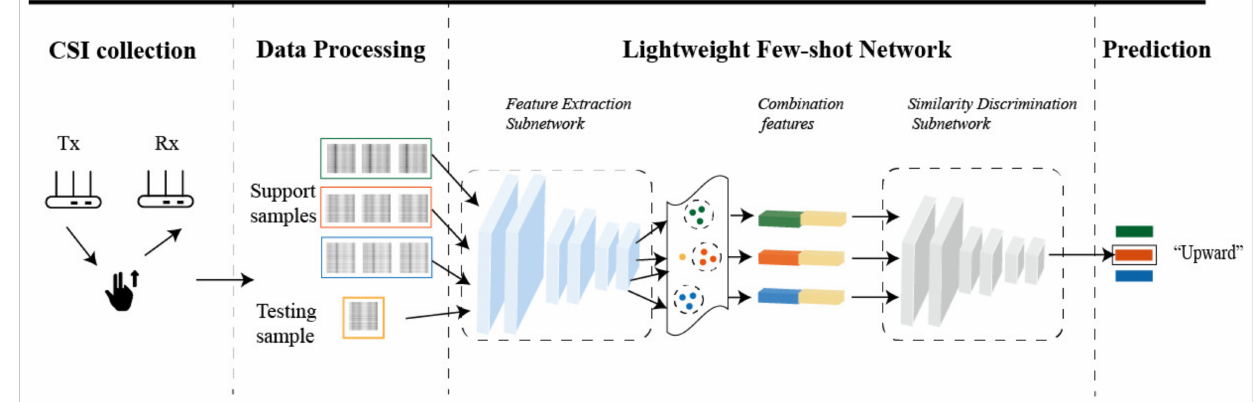
Figure 1. The framework of the Wi-Fi-based gesture recognition (WiGR) system contains four steps: (1) input the channel state information (CSI) data collected from the Wi-Fi environment; (2) process the CSI data; (3) feed the processed CSI data into the lightweight few-shot network; (4) train the network via an episode-based training strategy and output the predicted